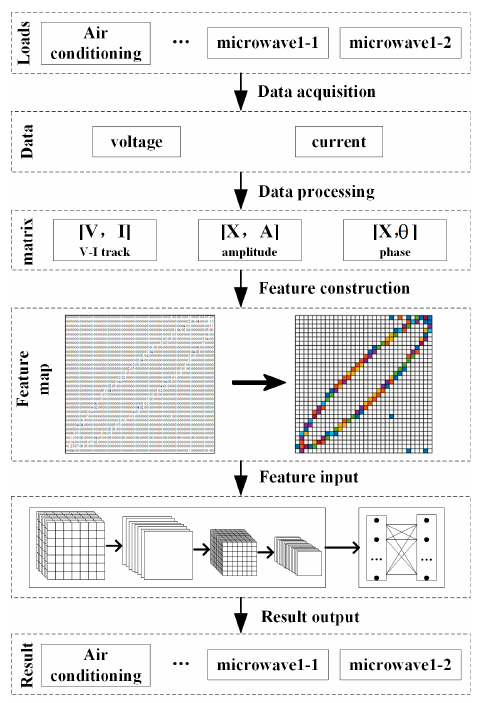
Figure 8. Identi fi cation fl ow chart. Figure 8. Identification flow